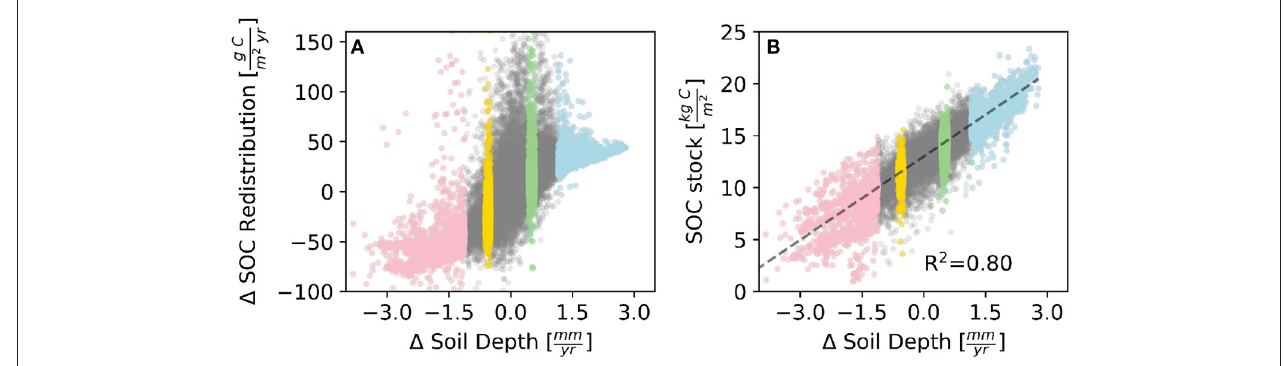
FIGURE 4 | The relationship between the annual rate of change of soil depth and (A) SOC redistribution, and (B) SOC stock averaged between years 85 and 90. A positive SOC redistribution means that the incoming SOC flux is higher than outgoing flux (resulting in accumulation), and vice-versa for negative values. The red, yellow, green, and blue dots correspond to 5% areas of fast erosion areas (Zone A), moderate erosion areas (Zone B), moderate deposition areas (Zone C), and fast depositional areas (Zone D), respectively, as shown in Figure 2a